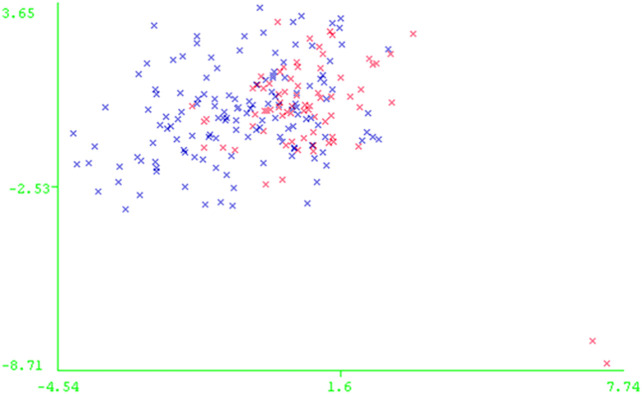
PCA plot of AASK patients in the reduced data: * Rapid Progressors and * Slow Progressors